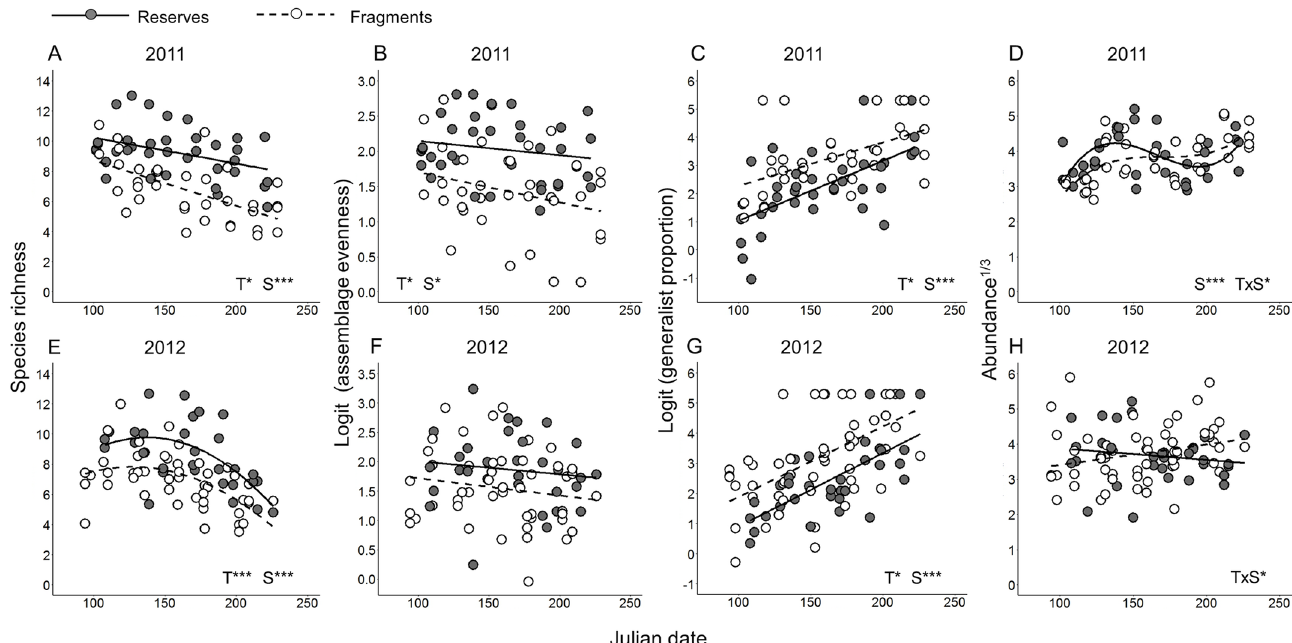
Fig 3. Temporal alpha diversity of native bees in reserveand fragment plots in 2011 (A-D) and 2012 (E-H). Scatterplots show (A,E) rarefied species richness, (B,F) logit-transformed rarefied assemblageevenness(Pielou’s J ), (C,G) logit-transformed proportions of individualsbelongingto generalistspecies, and (D,H) cube root-transformed number of bees collectedper temporalsample. All plots show regression lines to visualizedata trends. Significant main effects and interactionsfrom linear mixed-effectsmodels are indicatedon each graph: T = treatment, S = temporal sample. * P < 0.05, ** P < 0.01, *** P <